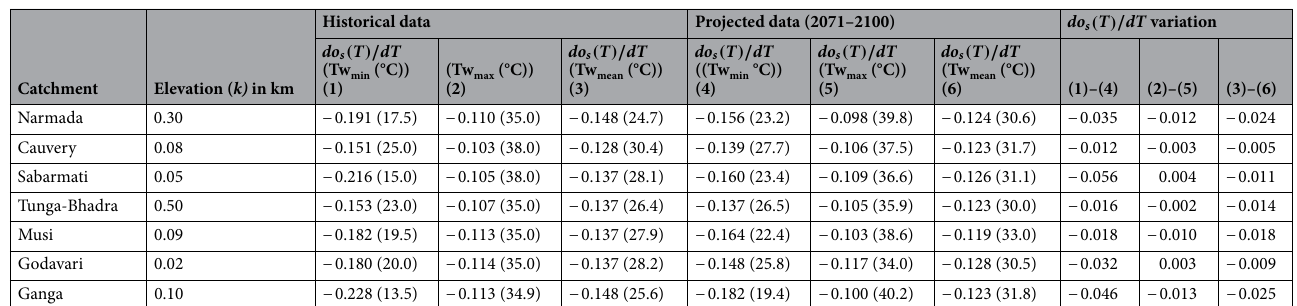
Table 1. The rate of change of oxygen saturation levels under a minimum, maximum, and average river water temperatures (in parentheses). ( do s ( T )/ dT ((mgO 2 /L)/°C)) for historical and projected (2071–2100) at respective elevations for seven Indian catchments. Set the Salinity ( S ) value for seven river catchments to